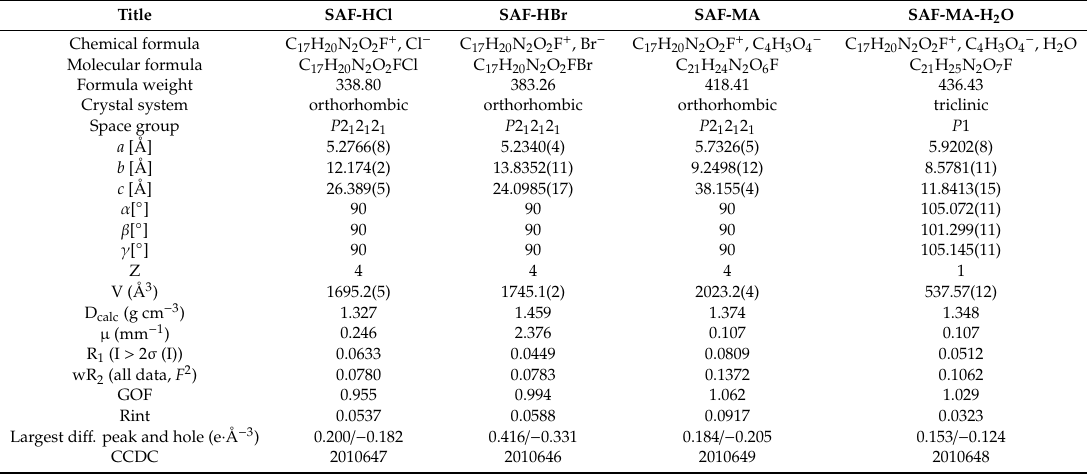
Table 1. Crystallographic parameters of safinamide and its pharmaceutical salts.